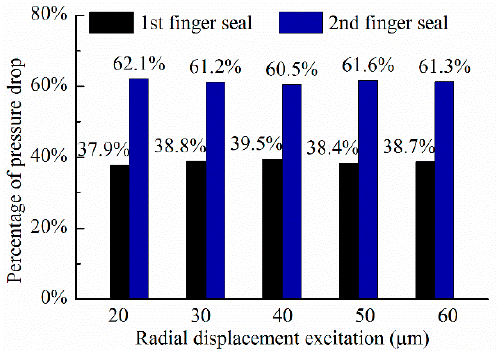
Figure 19. Effect of radial displacement excitation on the inter ‐ stage pressure drop characteristics.